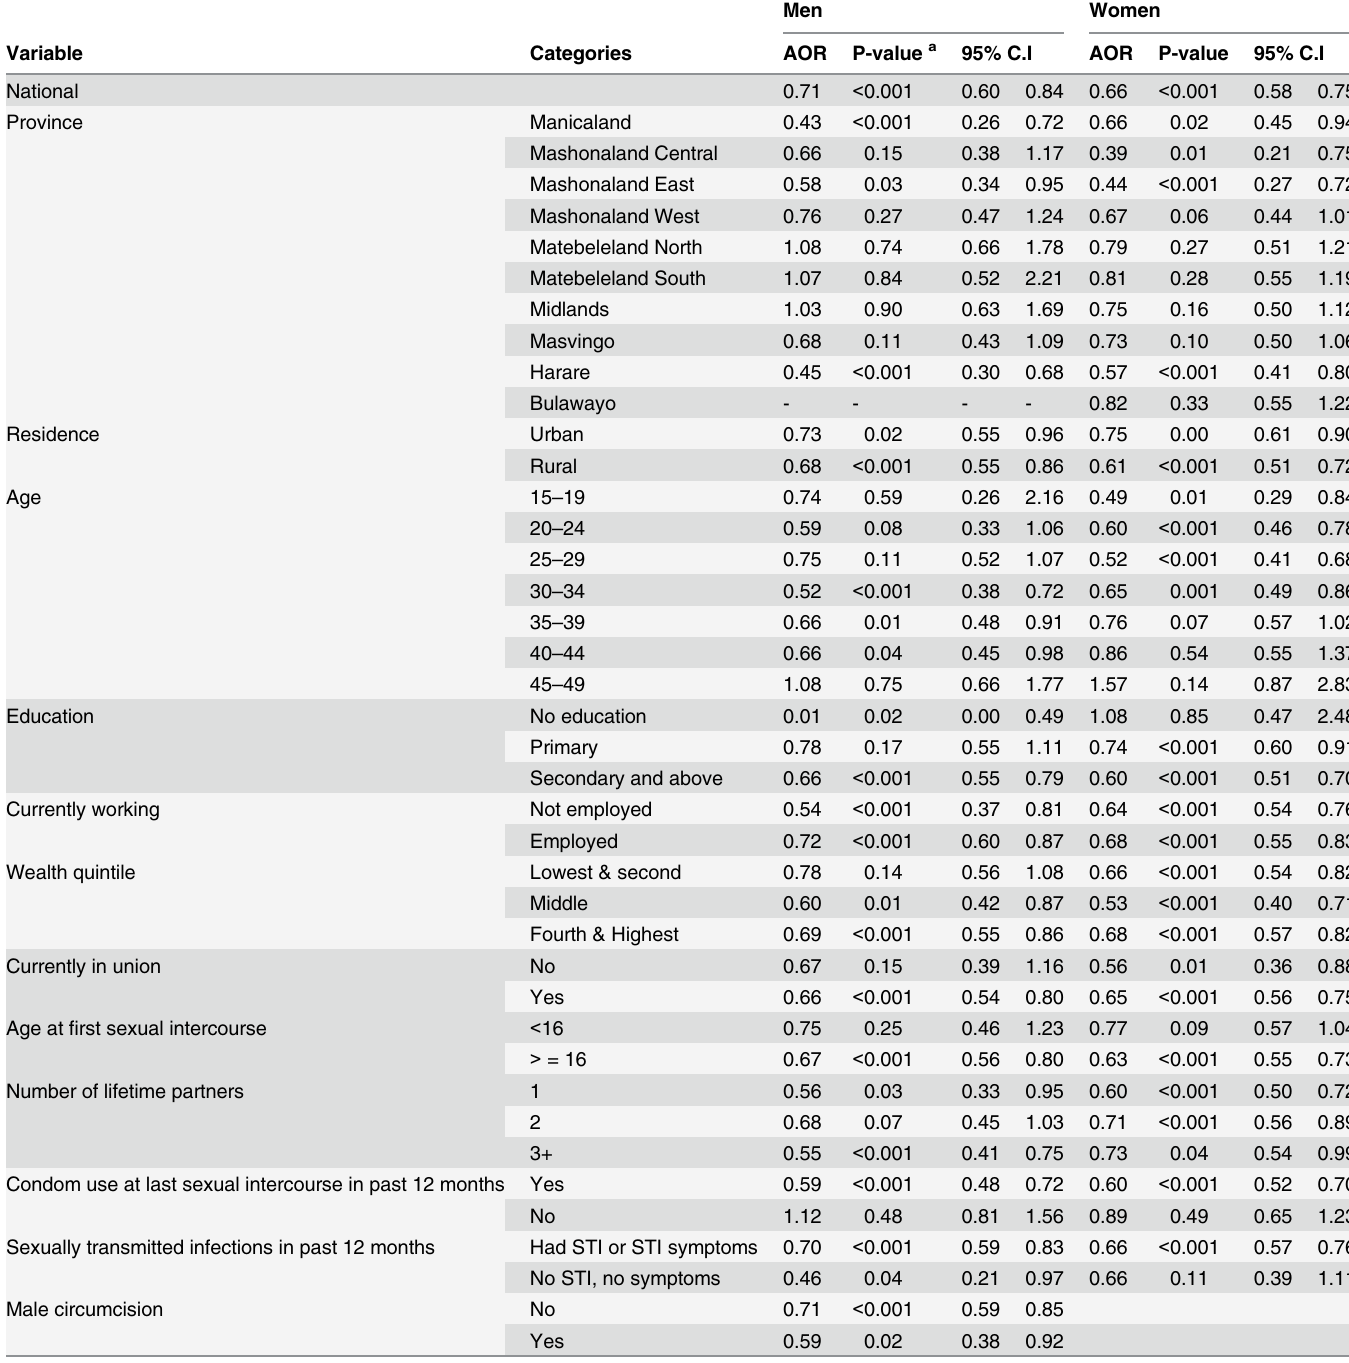
Table 2. Logistic regression of the factors associated with change in HIV prevalence among adults aged 15 – 49 years who were tested for HIV, ZDHS 2005/6 and